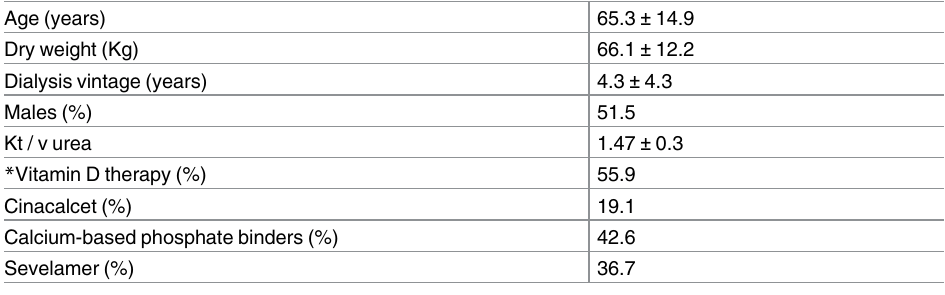
Table 1. Demographic and clinical characteristics of the study population. Data expressed as mean ± SD or